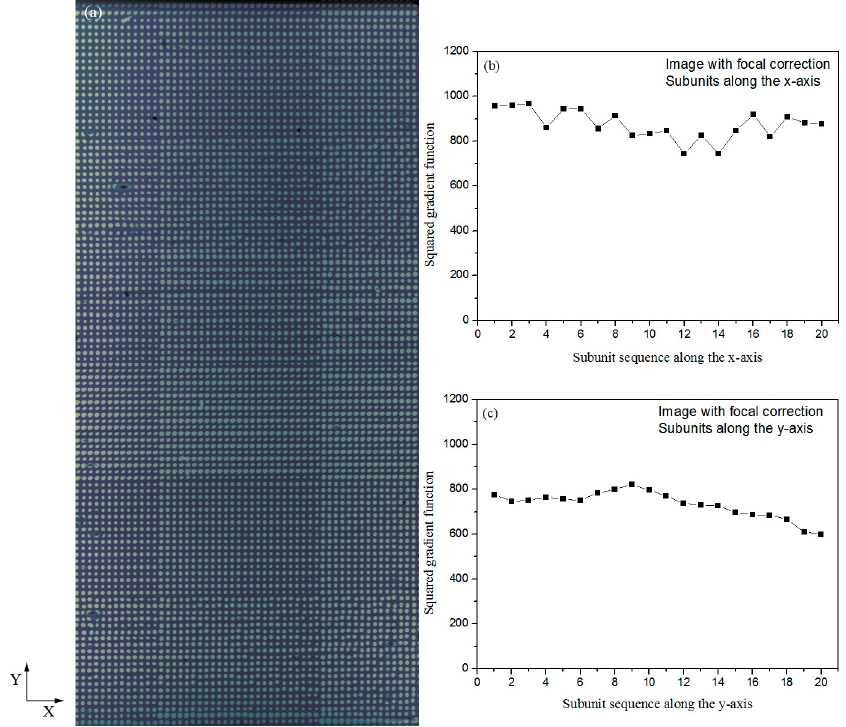
Figure 5. ( a ) An image of the same BBSA microarray obtained with the TIR OI-RD microscope and focal correction; ( b ) Squared gradient functions of 20 subunits along the x-axis with each unit having 35 × 1500 pixels. Subunit sequence begins from the left side of the microarray image; ( c ) Squared gradient functions of 20 subunits along the y-axis with each unit having 710 × 75 pixels. Subunit sequence begins from the top side of the microarray image.